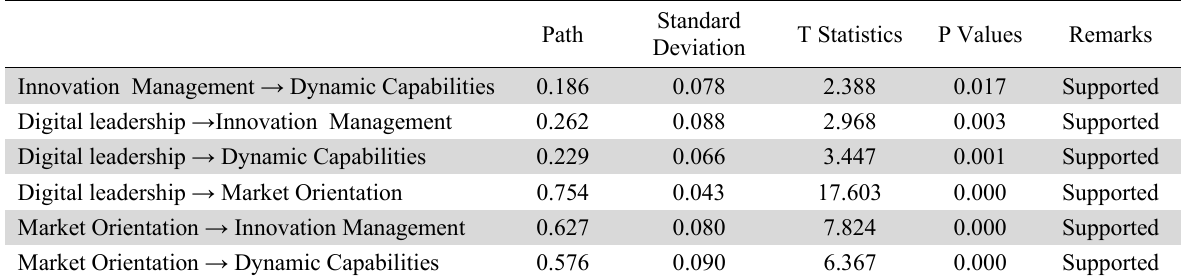
Partial Hypothesis Testing